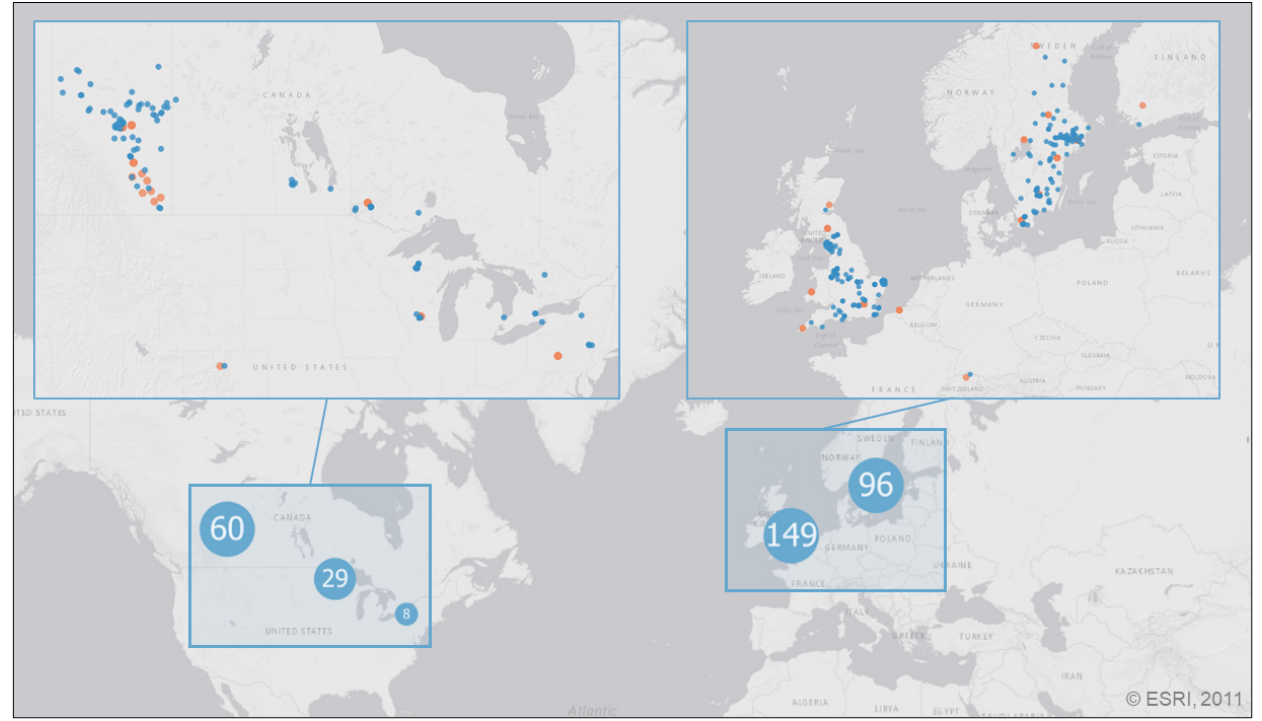
Figure 1. Distribution of the 343 lake sampling locations in the PCI dataset. Lake sampling points are clustered by proximity, where marker size and value indicate the number of unique locations represented by each point (light blue markers with white text). Enlarged sections show each lake sampling location (blue markers) along with the location of the 320 paired SSR stations (orange markers). Base map credit: ESRI, 2011.